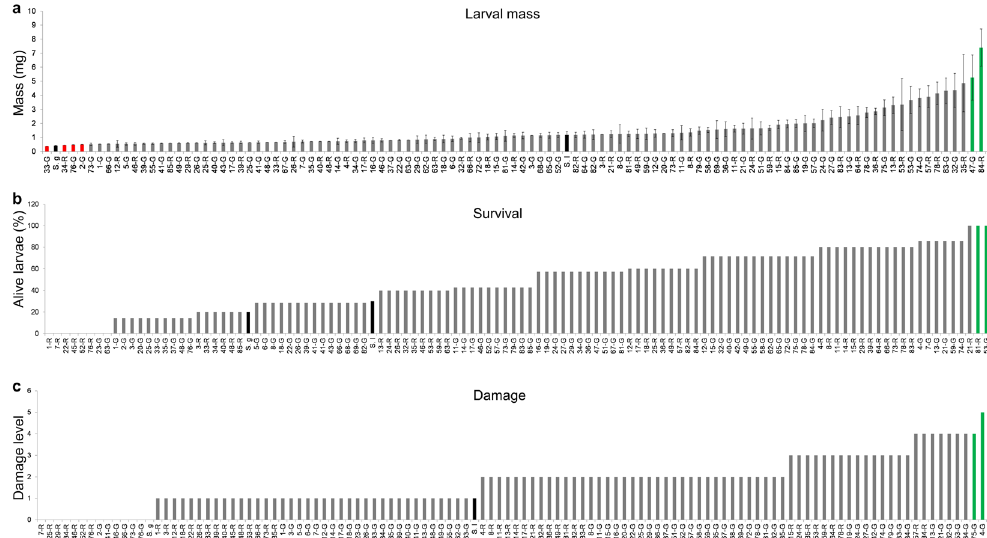
Figure 3. Variation in Colorado potato beetle performance on Solanum lycopersicum × S. galapagense recombinant inbred lines. ( a ) Average mass of surviving CPB larvae on each leaflet, ± SE if at least two larvae survived; ( b ) Percent survival of seven larvae that were placed on each leaflet. ( c ) Damage in the leaflet was ranked from 0 (no damage) to 5 (50% damage) and the number of RILs per damage level recorded after five days of feeding. Black bars show performance and survival on the parental lines ( S. lycopersicum , S.l ; S. galapagense , S.g ). Green bars represent individuals where CPB performance and survival were the highest, red bars represent recombinant inbred lines where CPB performance and survival were the lowest. Each bar represents an assay conducted with an individual